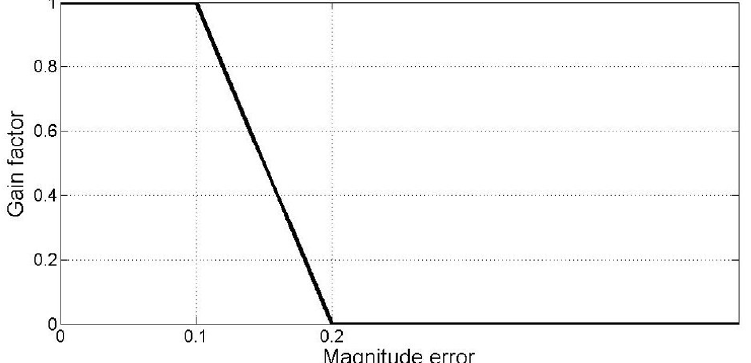
Figure 5. The gain factor function used in the adaptive gain to reduce the attitude error deriving from the external linear acceleration because of vehicle